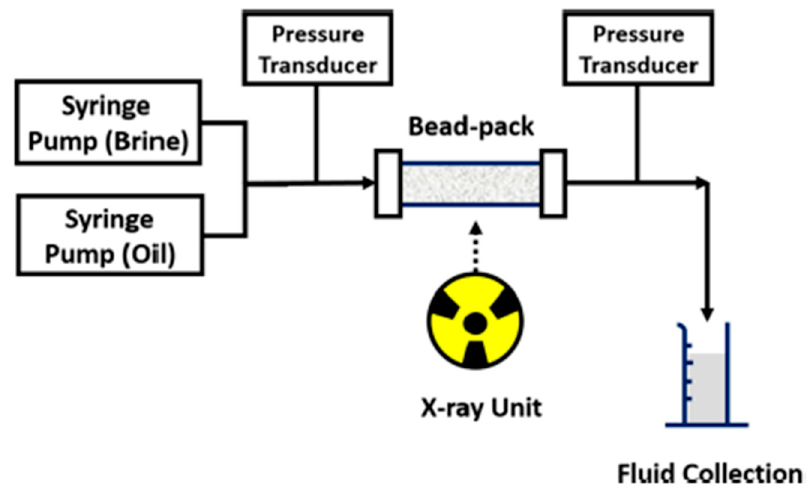
Figure 16. Schematic diagram of the experimental setup. Reprinted with permission from [57]. Copyright 2016 American Chemical Society.